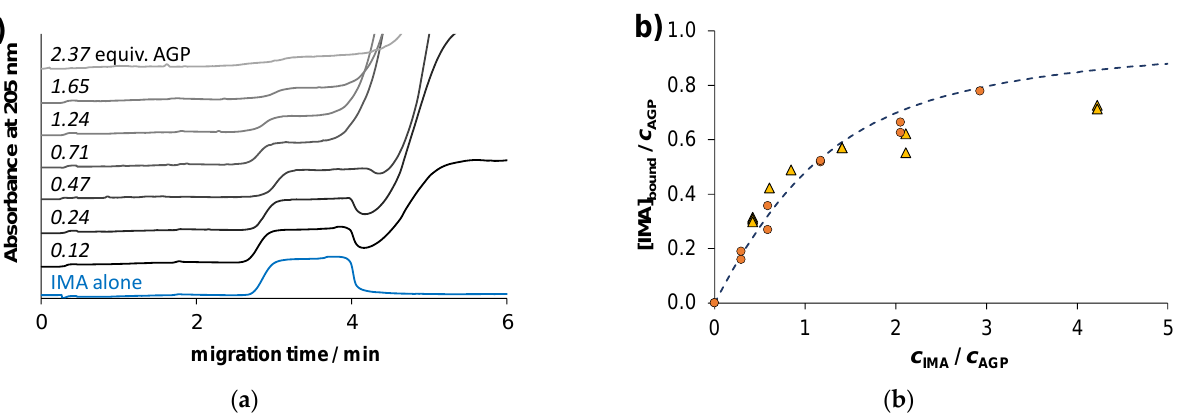
Figure 8. ( a ) Electropherograms recorded for the AGP – IMA system where the IMA concentration was constant and protein concentration varied. ( b ) Binding curve derived from the free IMA plateau heights of the same titration ( ● ) and the AGP – IMA titration ( ▲ ) together with the binding curve computed on the basis of the determined binding constant (log K ’ = 5.2 ± 0.1) [ c IMA = 15 μM (● ) 0 – 17 μM ( (cid:78) ); The three-dimensional fluorescence spectra in Figure 9 recorded for the AGP – IMA and HSA – IMA systems show well the differences between the binding affinities of the drug to the two proteins . The fluorescence of AGP (at λ EX : 280 nm, λ EM : 325 nm) reduced to ca. 60% upon addition of IMA and in turn the weak induced fluorescence of IMA (at λ EX : 280 nm, λ EM : 465 nm) appears in the spectrum. At the same time, light emission of HSA is barely affected by IMA and the induced fluorescence of the latter could not be observed. Favipiravir did not quench the fluorescence of HSA or AGP under the same conditions, and the presence of the proteins had no effect on the intense fluorescence band of FAVI (see Figure S13 for 3D spectra).